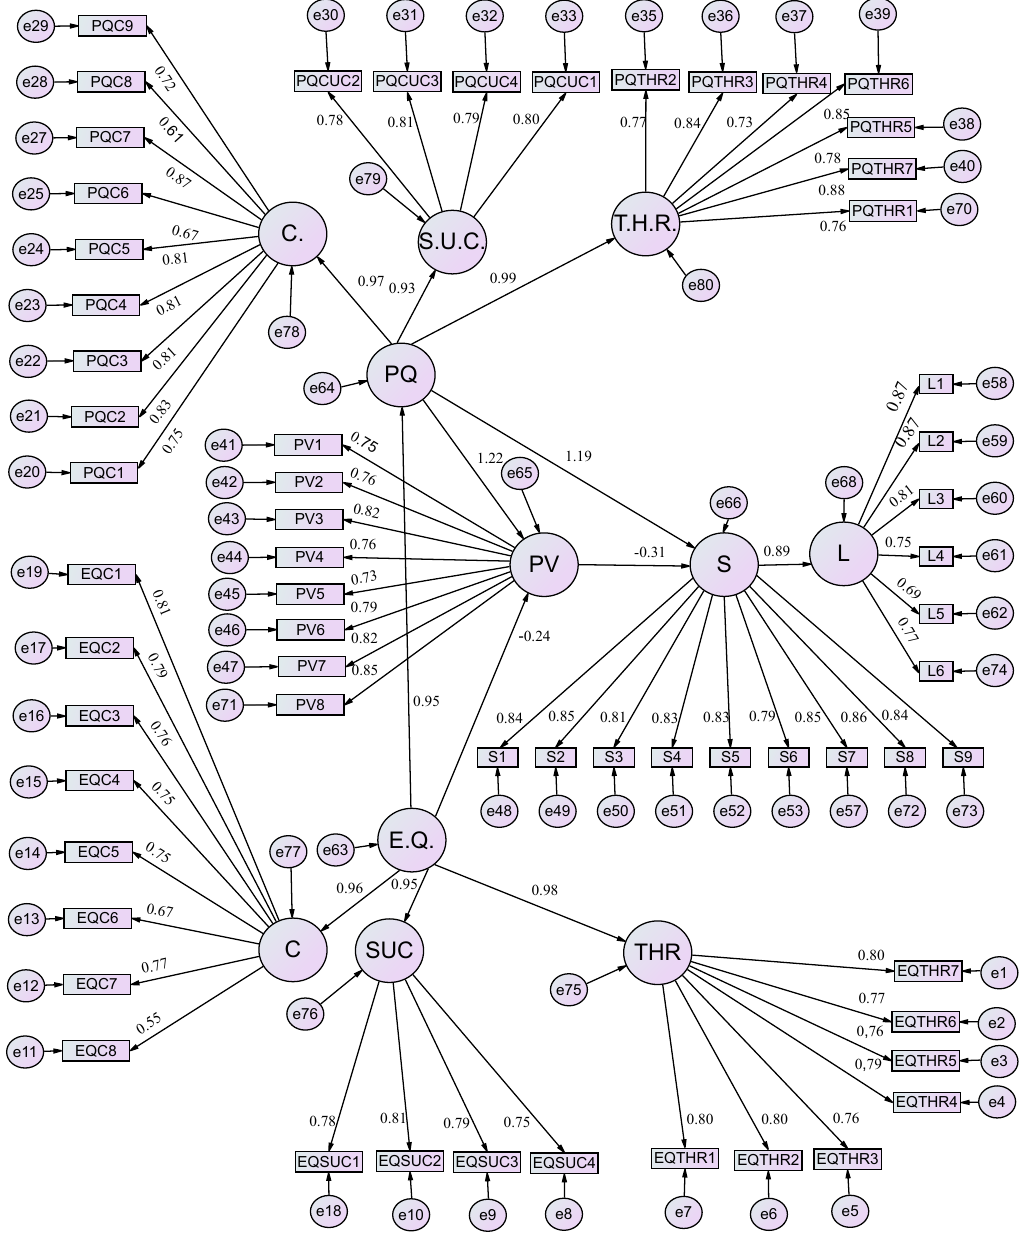
Figure 2. Path diagram of the proposed